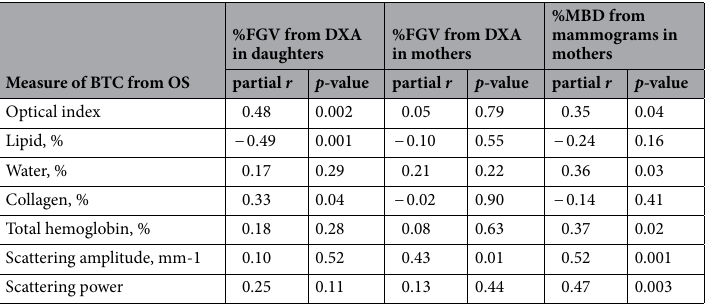
Table 3. Partial correlation coefficients comparing breast tissue composition measures from OS with relative measures of breast density from DXA and mammograms, adjusting for age and body mass index, in daughters and mothers from the Growth and Obesity Study in Santiago, Chile. BTC breast tissue composition, DXA dual- energy X-ray absorptiometry, FGV fibroglandular volume, MBD mammographic breast density, OS optical